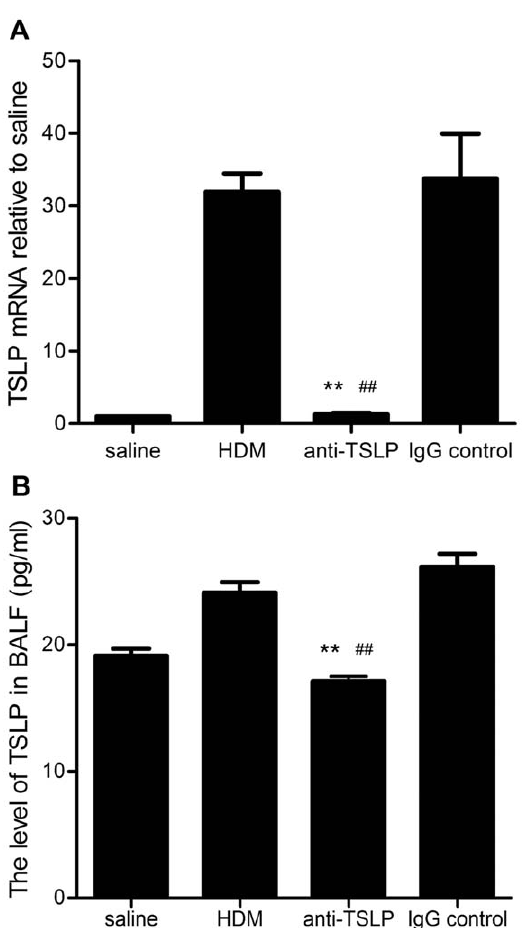
Figure 2. Chronic HDM exposure results in increased TSLP expression in mice. (A) The relative quantitative TSLP mRNA in the lung was detected using RT-PCR. (B) The TSLP protein concentration in the BALF was detected using an ELISA kit. The data shown represent the means 6 SEM (n=5). mRNA value=2 2 DD Ct , DD Ct= (Ct Target -Ct Actin ) of the treated mice-(Ct Target -Ct Actin ) of the saline control mice. **p , 0.01 groups (5 mice/per group), and both the protein and mRNA levels were determined in